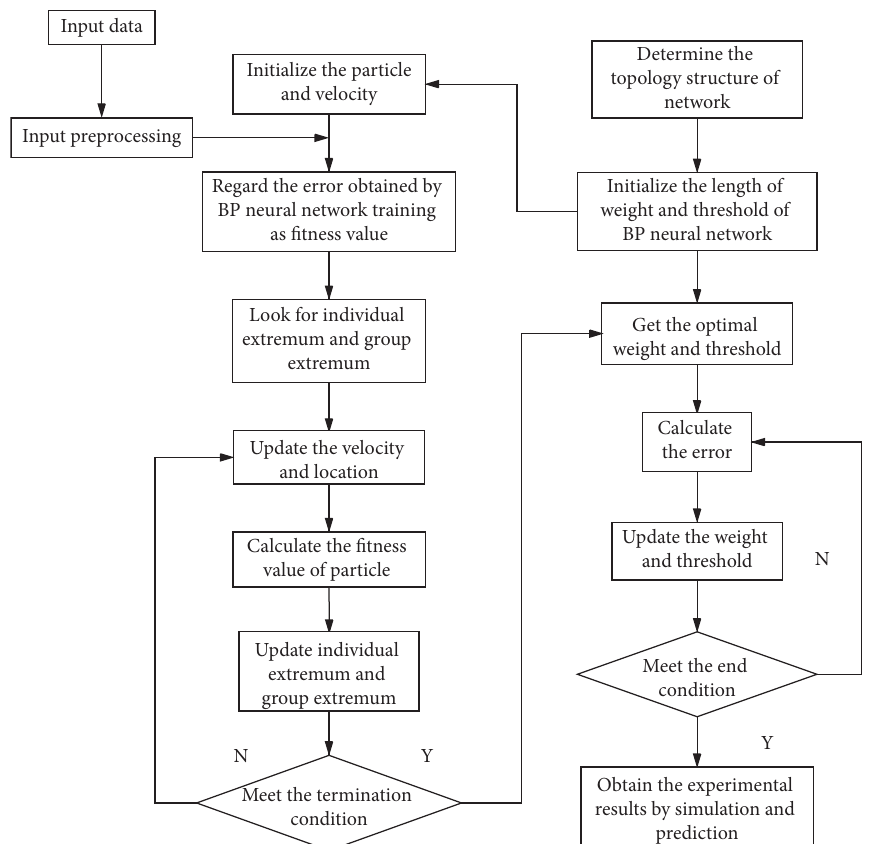
Figure 8: Flowchart of the PSO-BP